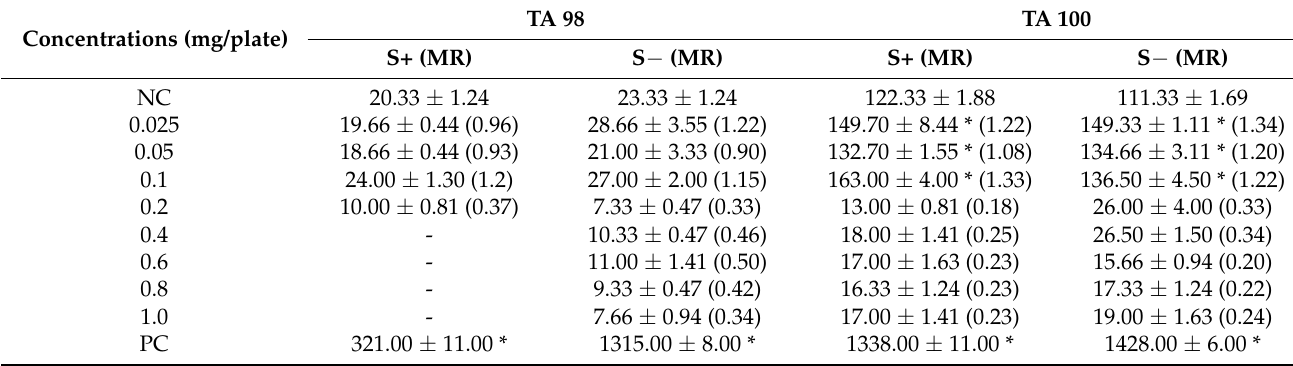
Table 1. Mutagenicity ratio (MR) of the Al expressed by the mean of reversals/plate ± standard deviation to TA98 and TA100 strains of S. Typhimurium with (S+) and without (S-) metabolic activation. TA 98 TA 100 Concentrations (mg/plate) S+ (MR) S −